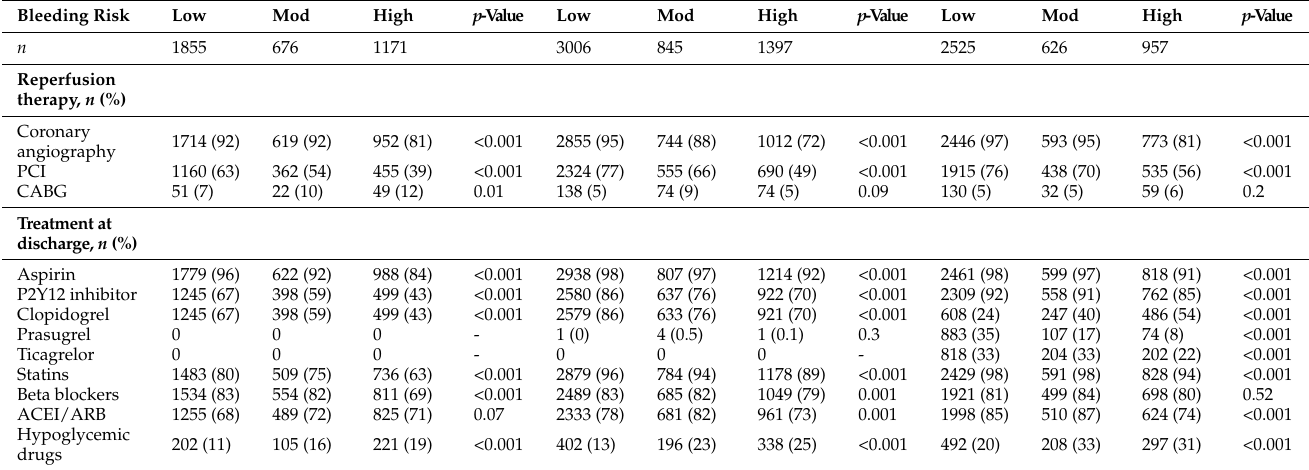
Table 2. In hospital treatment characteristics according to enrolment period and bleeding